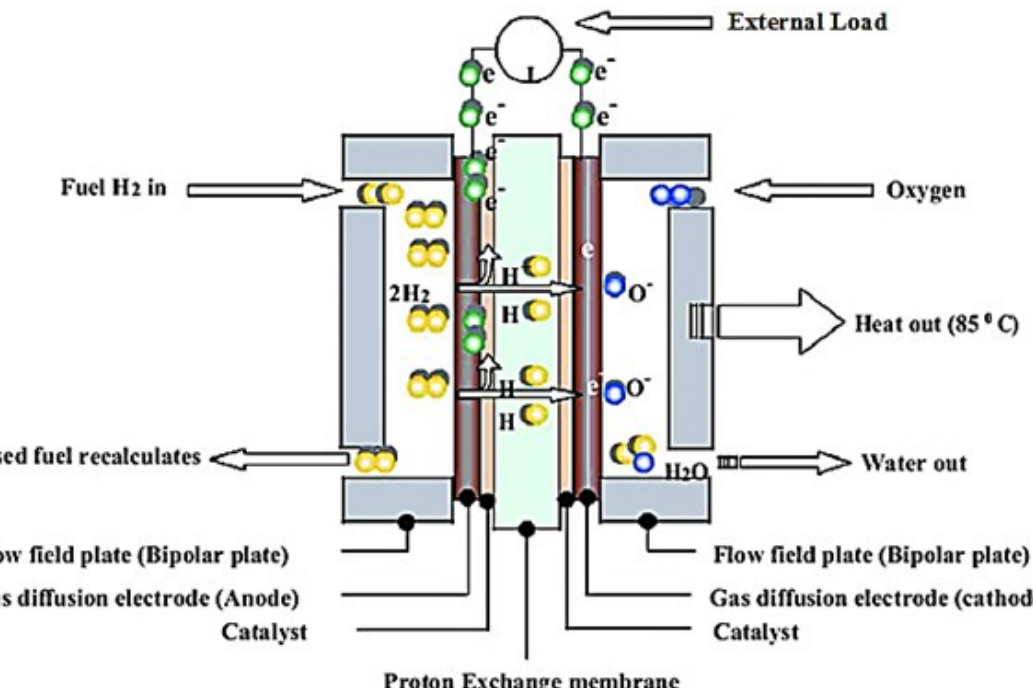
Figure 13. Schematic of working principle of polymer electrolyte membrane fuel cell